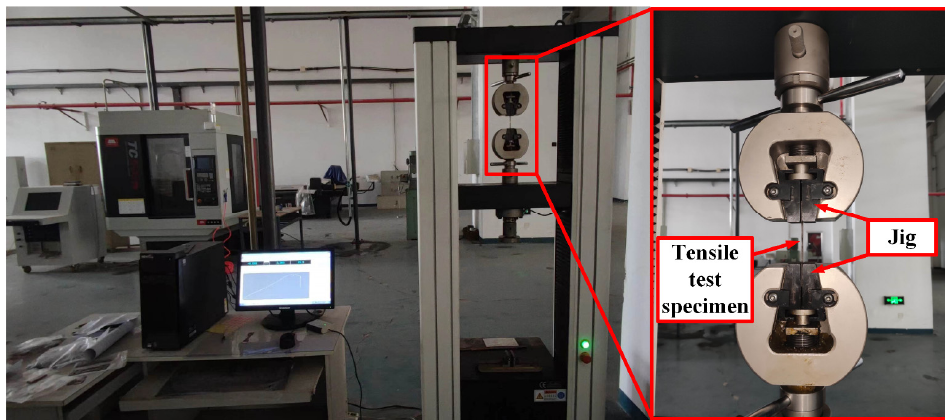
Figure 2. Universal material testing